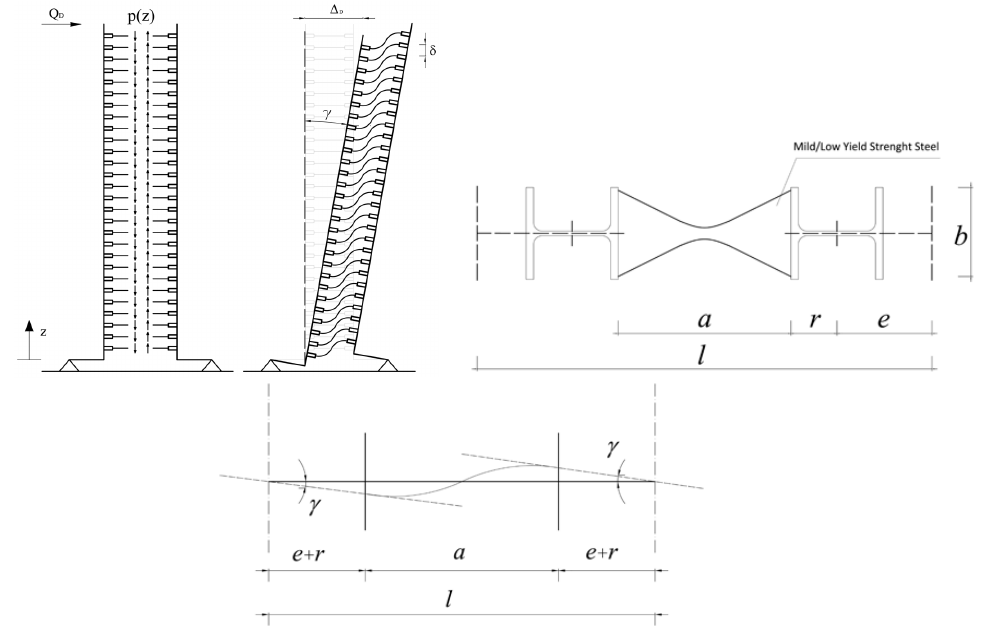
Figure 2. Eccentric Dissipative Column Model: Dissipative amplified